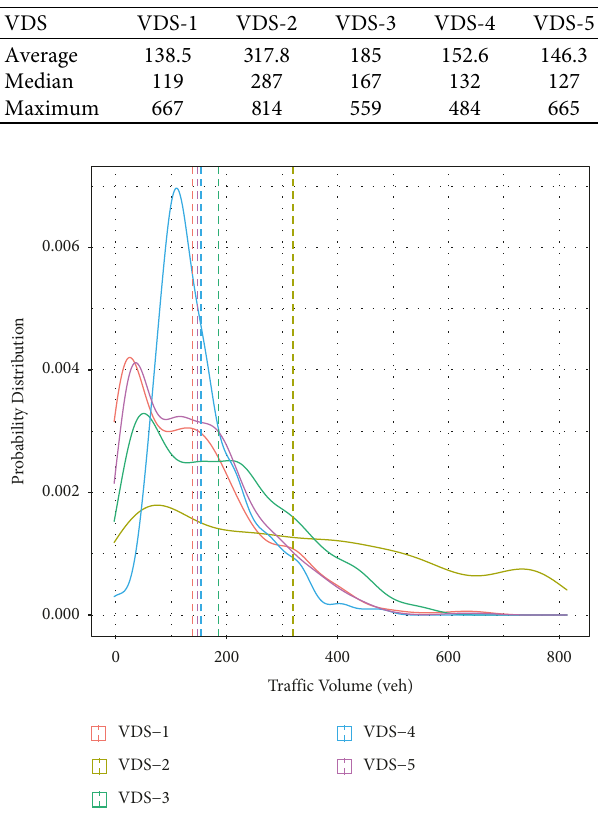
Figure 5: Kernel density estimation (KDE) probability distribution curve of traffic